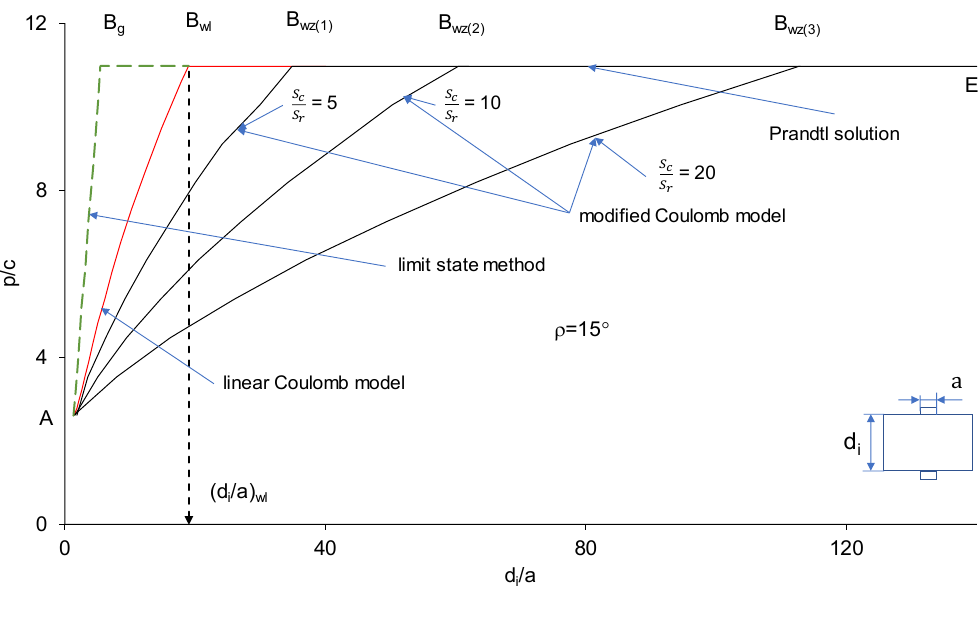
Figure 5: Limit load p/c as a function of d